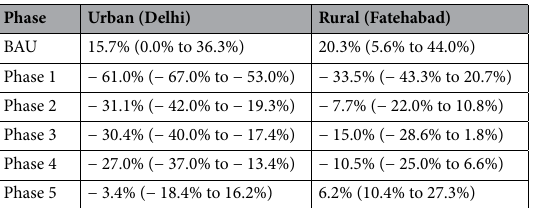
Table 1. Mean anomaly between the observed and expected NO 2 concentrations for each lockdown Phase in 2020. The range corresponds to 95% prediction